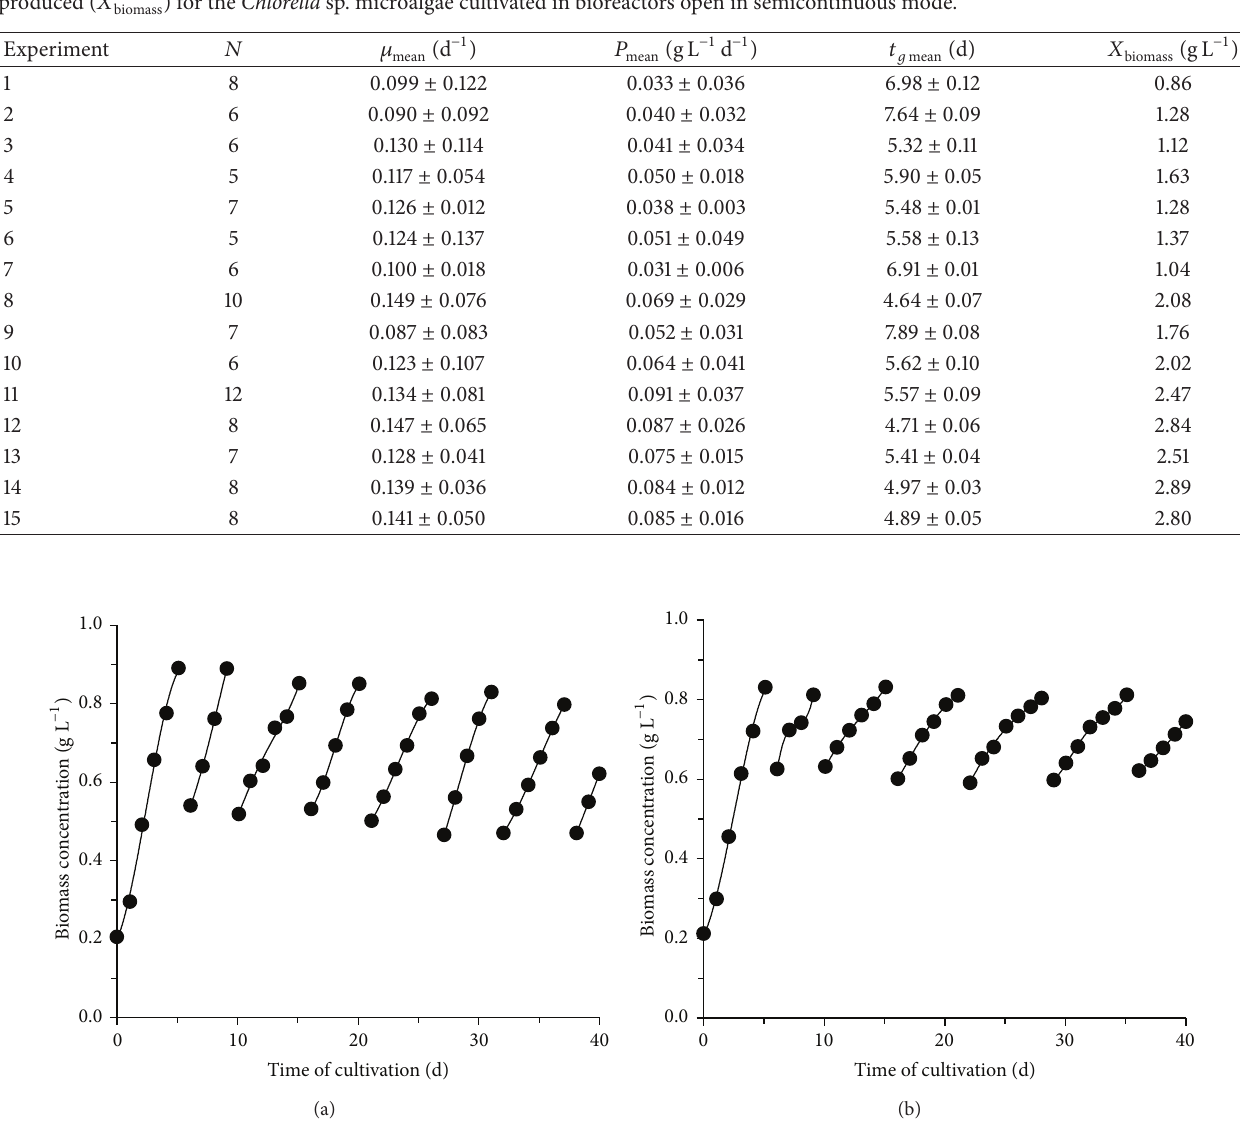
), productivity ( 𝑃 ), generation time (mean 𝑡 𝑔 ), and concentration of biomass mean mean